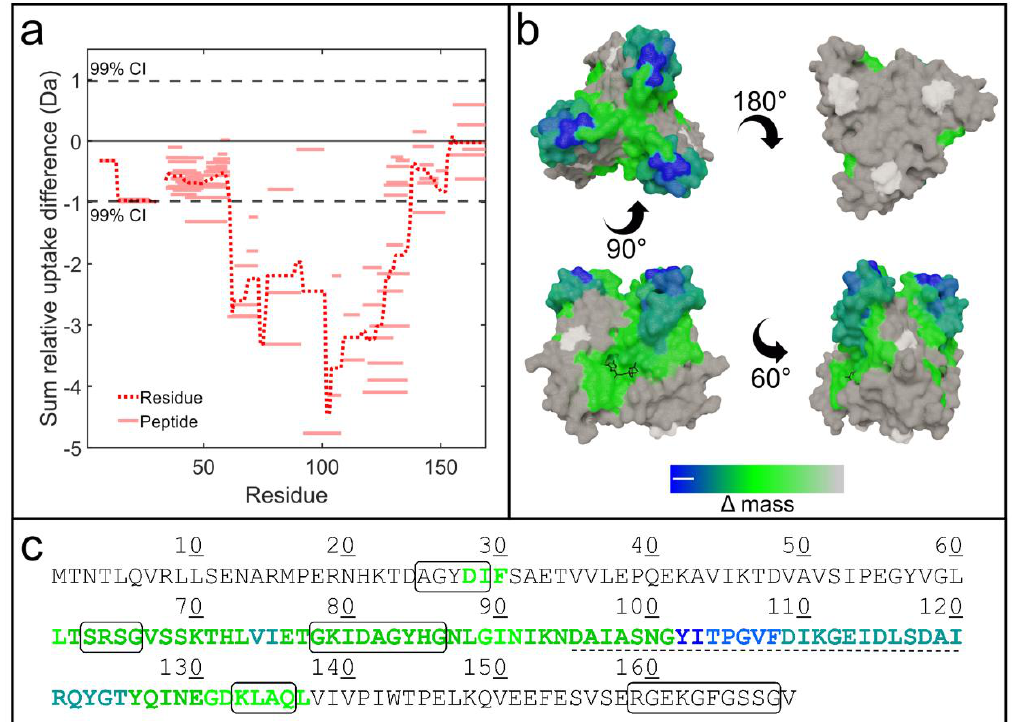
Figure 3. Hydrogen deuterium exchange mass spectrometry (HDX-MS) results for DUT ϕ 11 upon mixing with Stl. ( a ) HDX di ff erence plot showing the ∆ mass of each peptide (solid lines) as well as the average amount per residue (dotted line). The dashed lines represent the 99% confidence bands evaluated over the whole dataset. ( b ) X-ray crystal structure (PDB ID 4GV8 [23]) of DUT ϕ 11 colored according to HDX-MS di ff erence data following the color gradient shown at the bottom of the panel; substrate analogue dUPNPP is also shown as black sticks in order to ease visualization of the active sites (views: top, bottom, sides). Regions which could not be probed by HDX-MS are shown in white. ( c ) Sequence of the DUT ϕ 11 is shown, where the conserved active site building motifs are boxed and the phage specific insert is underlined with a dashed line. Letter coloring is according to HDX di ff erence data.